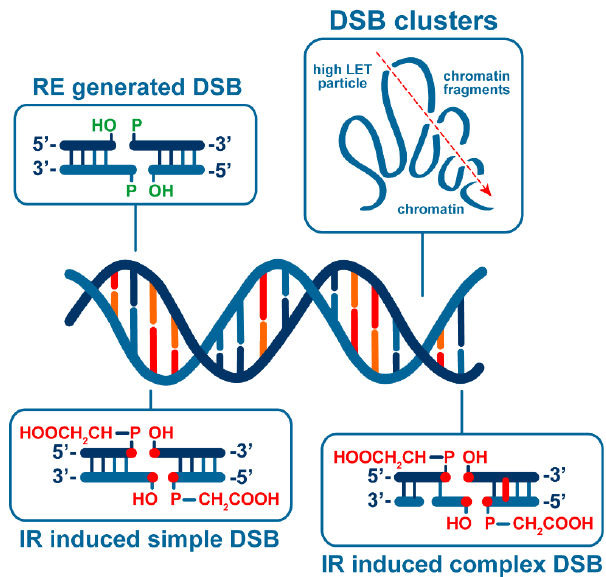
Figure 5. Concepts utilized in the classification of DSBs according to their degree of complexity. REs-generated DSBs break the DNA without chemically altering its nucleotides and are therefore considered the simplest form of DSBs (upper left box). IR induces DSBs by chemically altering at minimum two nucleotides in opposite strands mainly from ionization events within an ionization cluster (lower left box). The chemical entities generated in this way at the ends vary and need to be removed during DSB processing. This DSB is therefore more “complex” than that generated by REs. Since an ionization cluster may contain more than two events, the DSBs generated may be accompanied by additional forms of DNA damages near the DSB in the form of either additional single strand breaks or base damages. This generates DSBs of higher “complexity” in the sense that they will need more extensive processing (lower right box). Occasionally, particularly when cells are exposed to high LET particles, multiple DSBs are generated in some proximity (upper right box). The chromatin fragments generated in this way may be lost and are likely therefore to destabilize chromatin and compromise DSB processing. We therefore define them here as an additional level of DSB complexity. The consequences of defined generation of DSB clusters in cells are discussed in detail in the text.